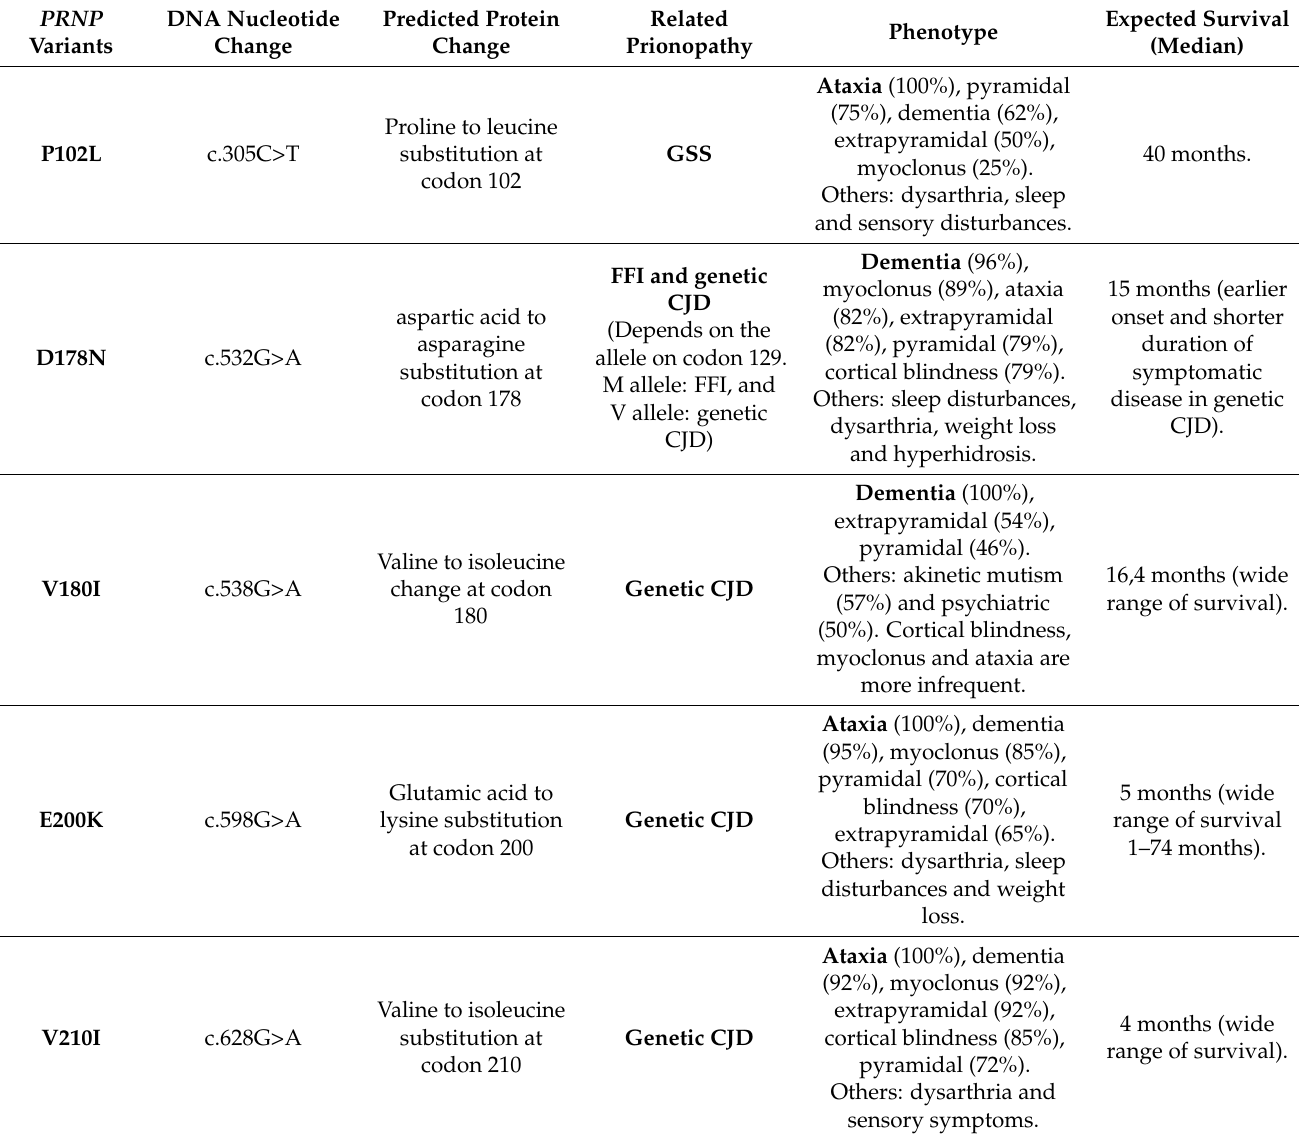
Table 2. Summary of the most frequent PRNP variants. Adapted from Ladogana et al., 2018